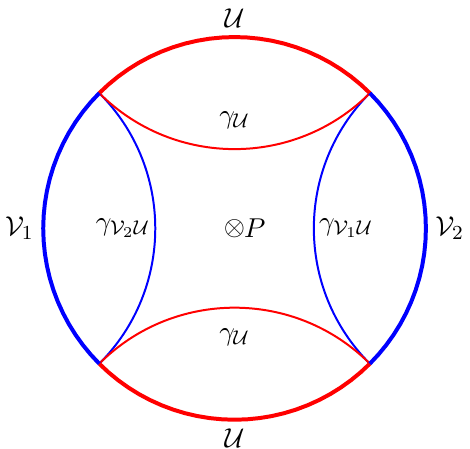
Figure 3. An example set-up for the proof of the privacy-duality theorem. We’ve taken a simple case, where U has only two connected components and the overall state is pure. In the case shown there is a bulk Cauchy slice Σ which contains both of γ and γ . In this case, the proof shows V 1 U V 2 U that a private curve Γ crosses Σ at a point P which is inside E , inside E , and outside E . P V 1 U V 2 U U It follows that E = E . Whenever the minimal extremal surface homologous to U is U 6 V 1 U ∩ E V 2 U unique, this implies I ( V : V ) is O (1 /G ) 1 2 | U N